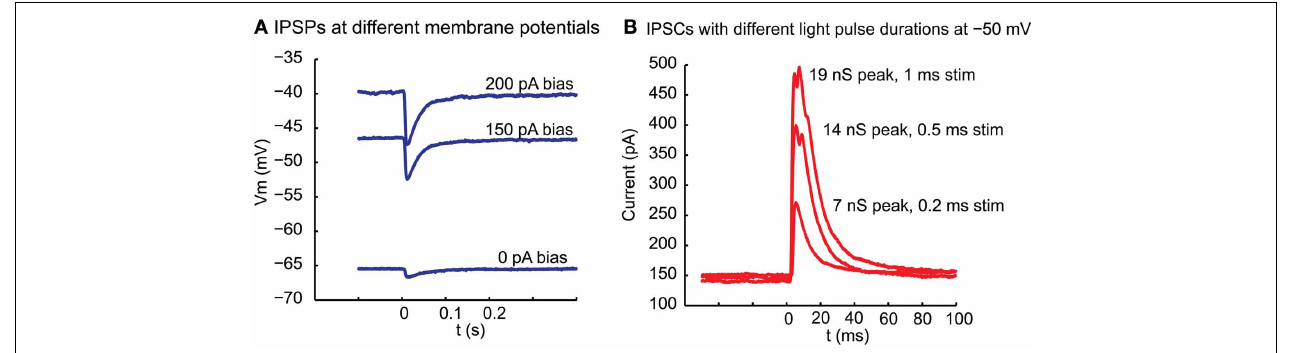
FIGURE 2 | Inhibitory potentials and underlying currents resulting in motor thalamus from local ChR2 activation in nigral termination areas. (A) At the time indicated by 0 a 10ms light pulse was delivered from a blue laser light source to the slice via a glass fiber. The fiber was held with a micromanipulator and the tip manually placed close to the brains slice with the light cone pointed at VM. The baseline membrane potential at the time of stimulation was controlled with a bias current injection through the recording